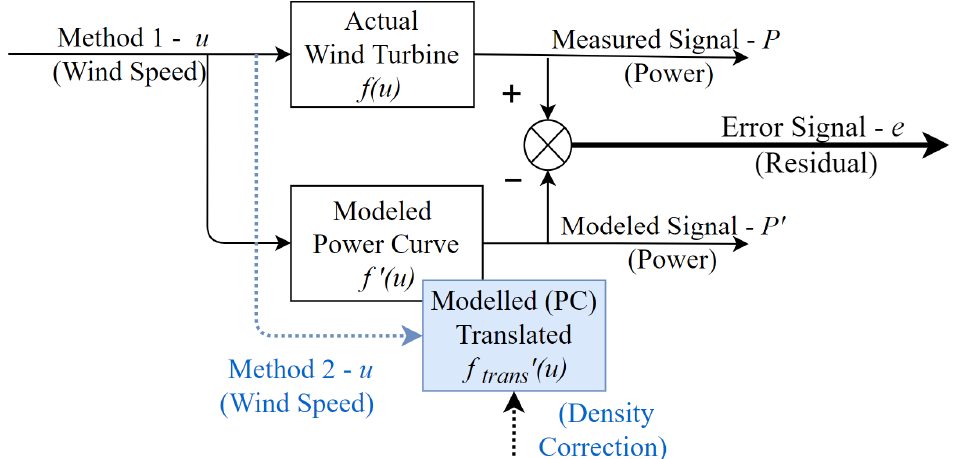
Figure 1. Overview of fault detection methods based on residual generation. Residual is generated using wind speed in Method 1; Method 2 uses wind speed, data translation and density